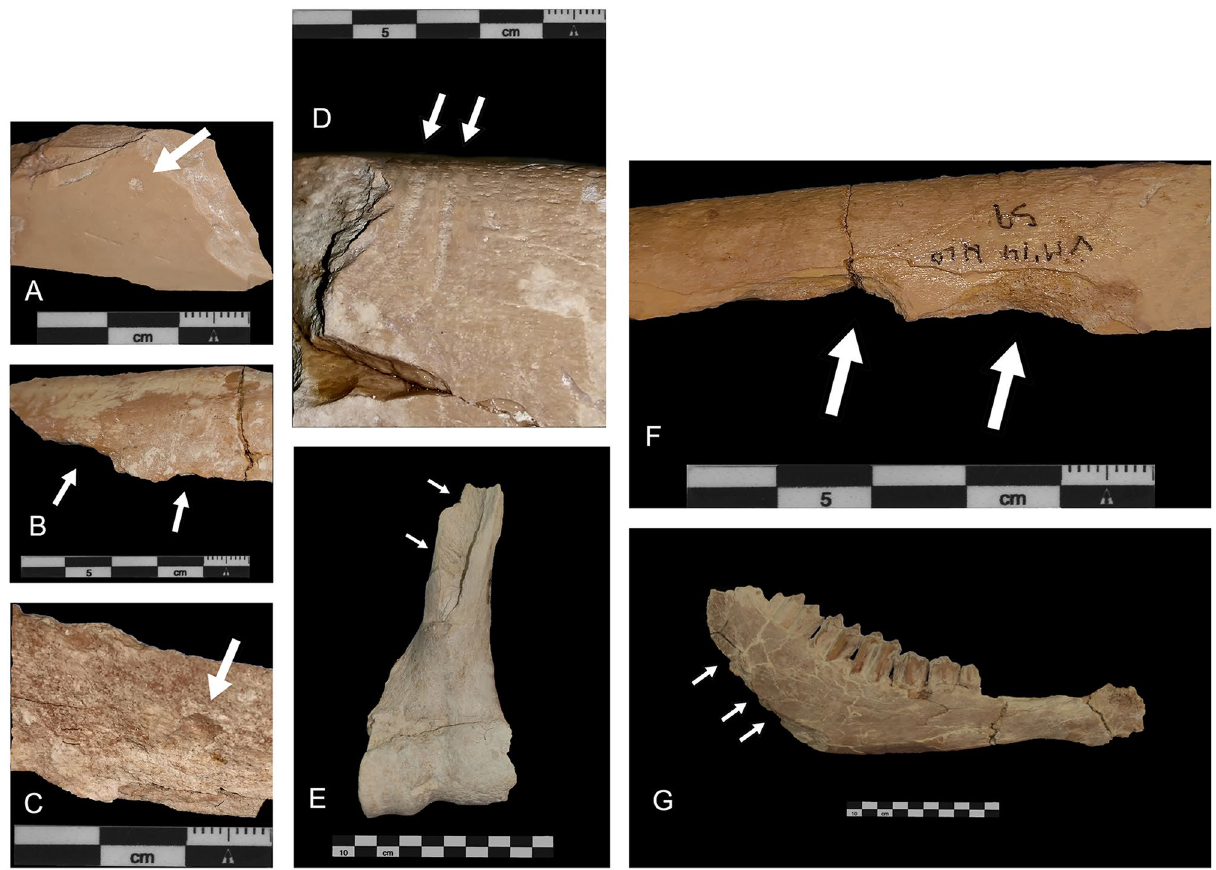
Figure 8. ( A ) A single pit on a long bone fragment; ( B ) Pseudo-notches on a long bone fragment; ( C ) a single pit on an non identifiable bone splinter; ( D ) Two scores on a long bone diaphysis; ( E ) Evidences of proximo- distal consumption of an E. altidens right humerus, with furrowing marks in the medial diaphysis; ( F ) Double notch on a long bone fragment; ( G ) Furrowing on the jaw angle and ramus of a Bison sp.